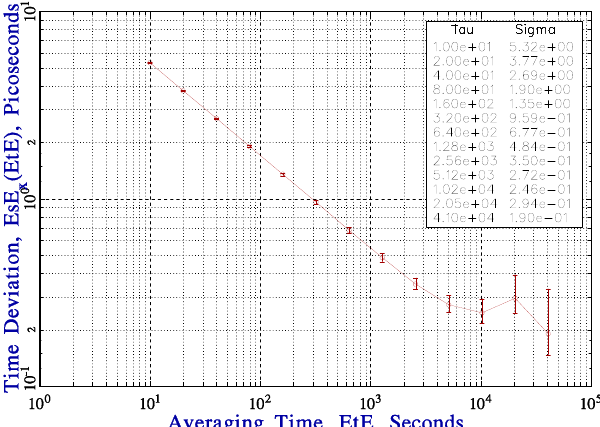
Figure 12. Time deviation of the entire TCSPC experiment [20]. In the sense of TDEV the long-term detection stability is better than 200 fs after several hours. In other words, it is meaningful to process data collected in several hours acquisition.